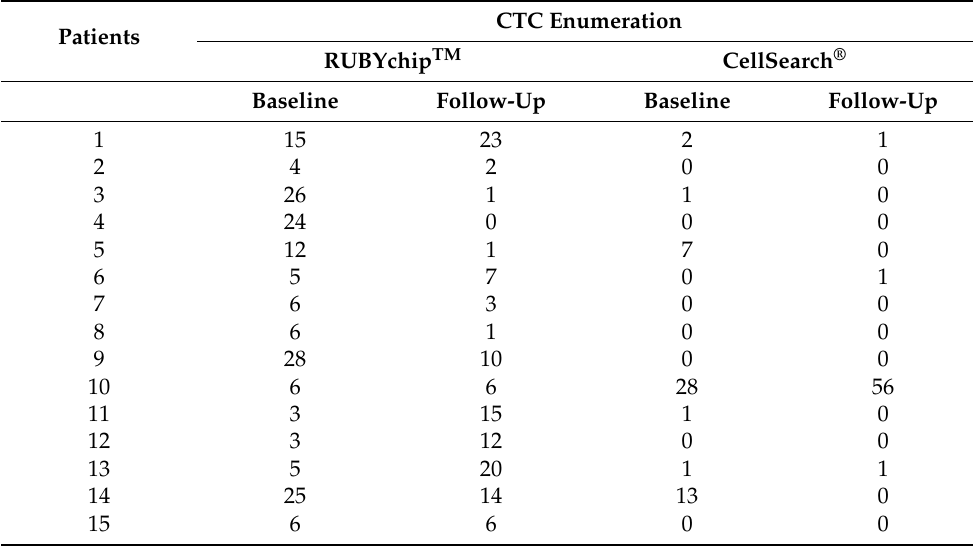
Table 3. Number of CTCs isolated by the RUBYchip™ and the CellSearch ® in the 15 metastatic breast cancer patients, at both time